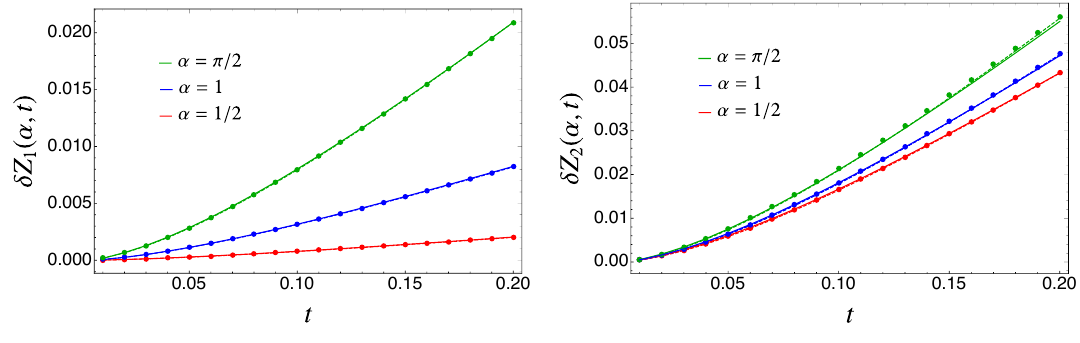
Figure 3 . Subtracted universal charged entropy (cid:14)Z ( (cid:11); t ) in eq. (4.18). Left (right) panel is for n = 1 ( n = 2). The dashed lines are the small t expansion in eq. (4.12) for n = 1 while the solid lines